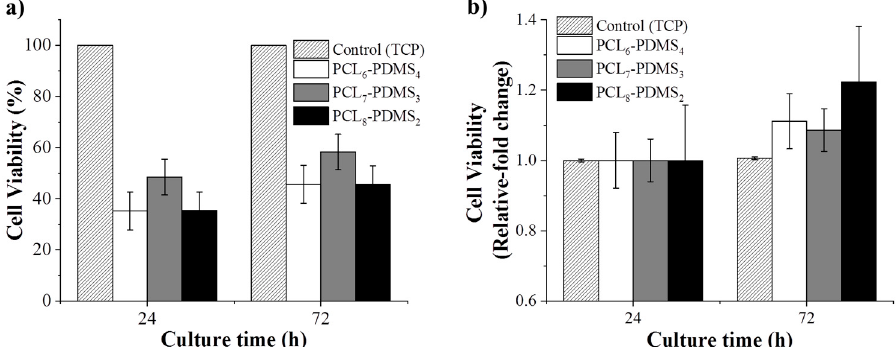
Figure 8 . The biocompatibility of PCL-PDMS nanofiber mesh based on ( a ) viability percentage and ( b ) relative fold change relative to the control group.